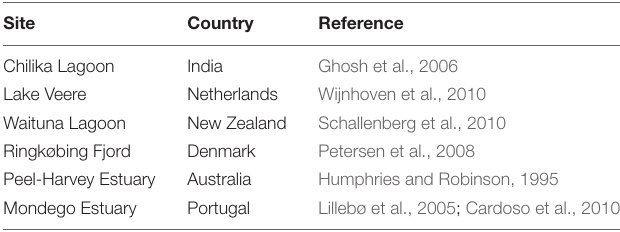
TABLE 1 | Examples of reported cases of hydrological engineering (ecoengineering with ecohydraulics) to mitigate eutrophication in coastal lagoons and